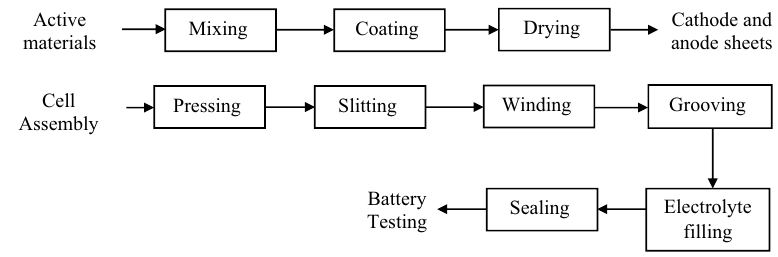
Figure 2: Cu - foil modi fi cation for AFLB production fl ow